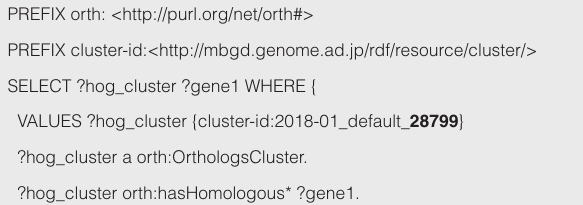
Figure 4. Both figures can be used as a guide in formulating SPARQL queries, by following the directions of the arrows in order to formulate triple patterns. Since both the MBGD and the OMA models rely on the ORTH ontology (Fernández-Breis et al. , 2016), the two graph structures are very similar and therefore SPARQL queries can be formulated with only minor differences for both data sources. Figure 5 illustrates the data model of the portion of the EBI RDF graph describing orthology information. In contrast to OMA, OrthoDB and MBGD, EBI only provides pairwise orthologous genes.